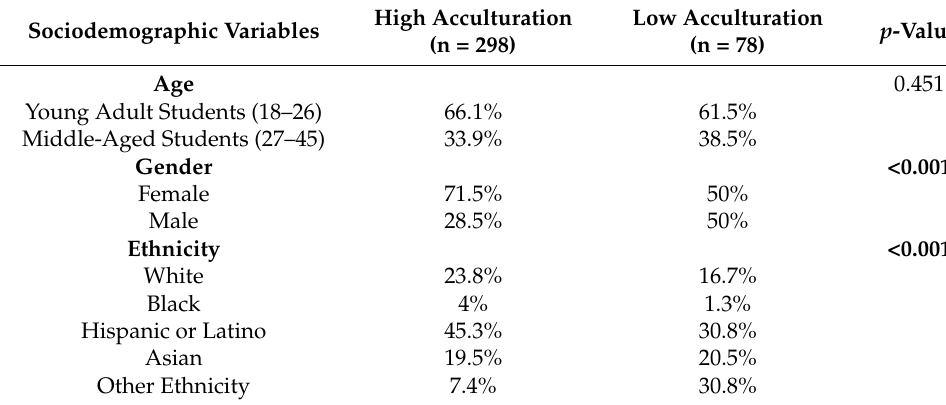
Table 3. Characteristics of foreign-born college students based on acculturation